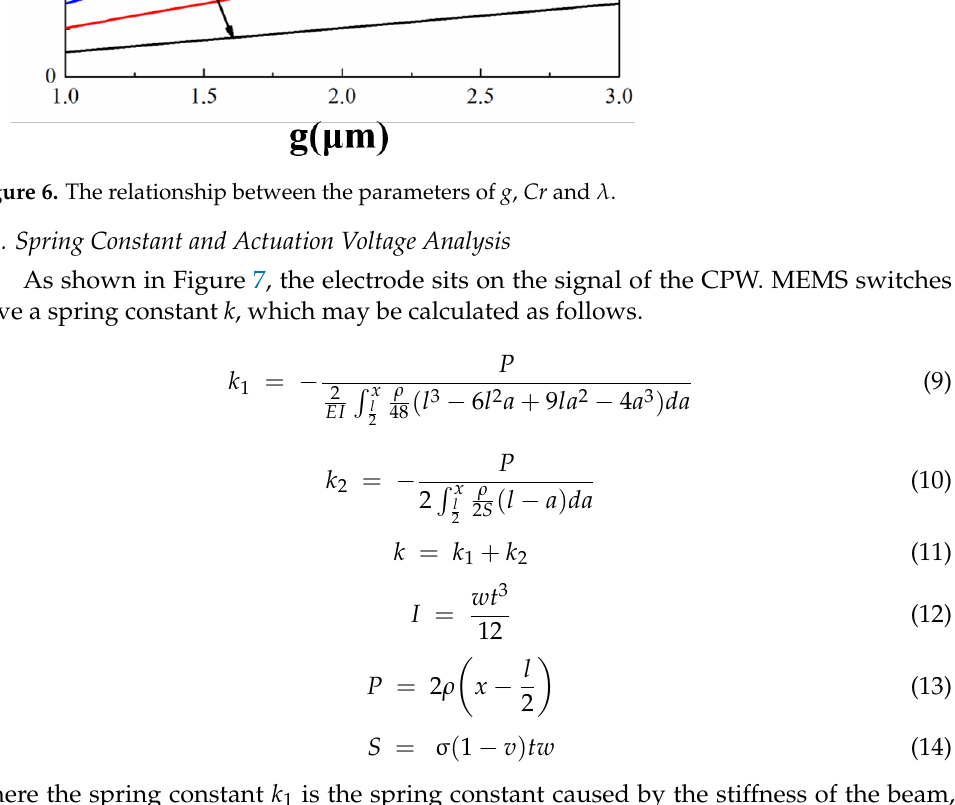
Figure 7. Electrode topology of the MEMS switch.